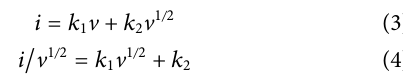
Frontiers in Materials |